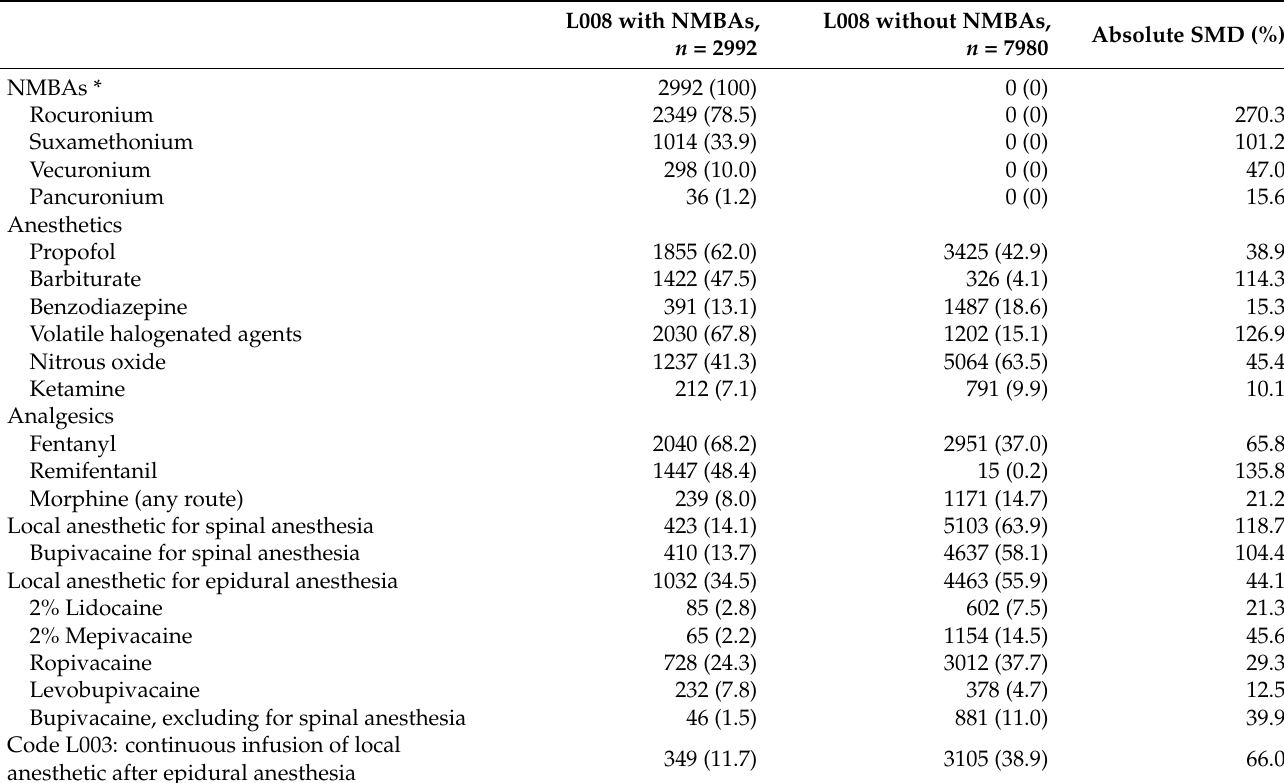
Table 2. Comparison of intraoperative drugs used in the study cohort with general anesthesia claim code (L008) according to the use of neuromuscular blocking agents